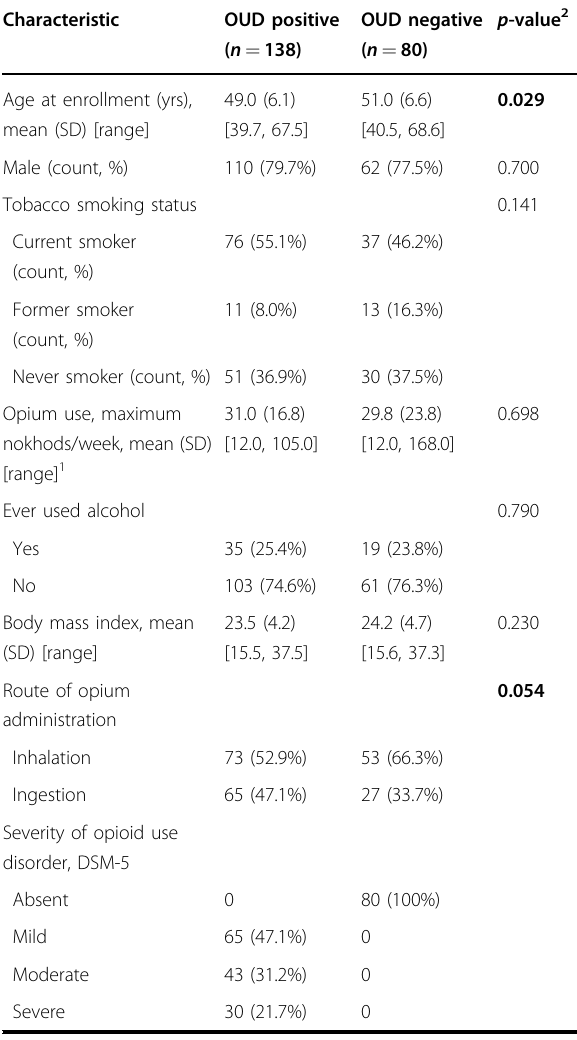
Table 1 Subject characteristics of high opium